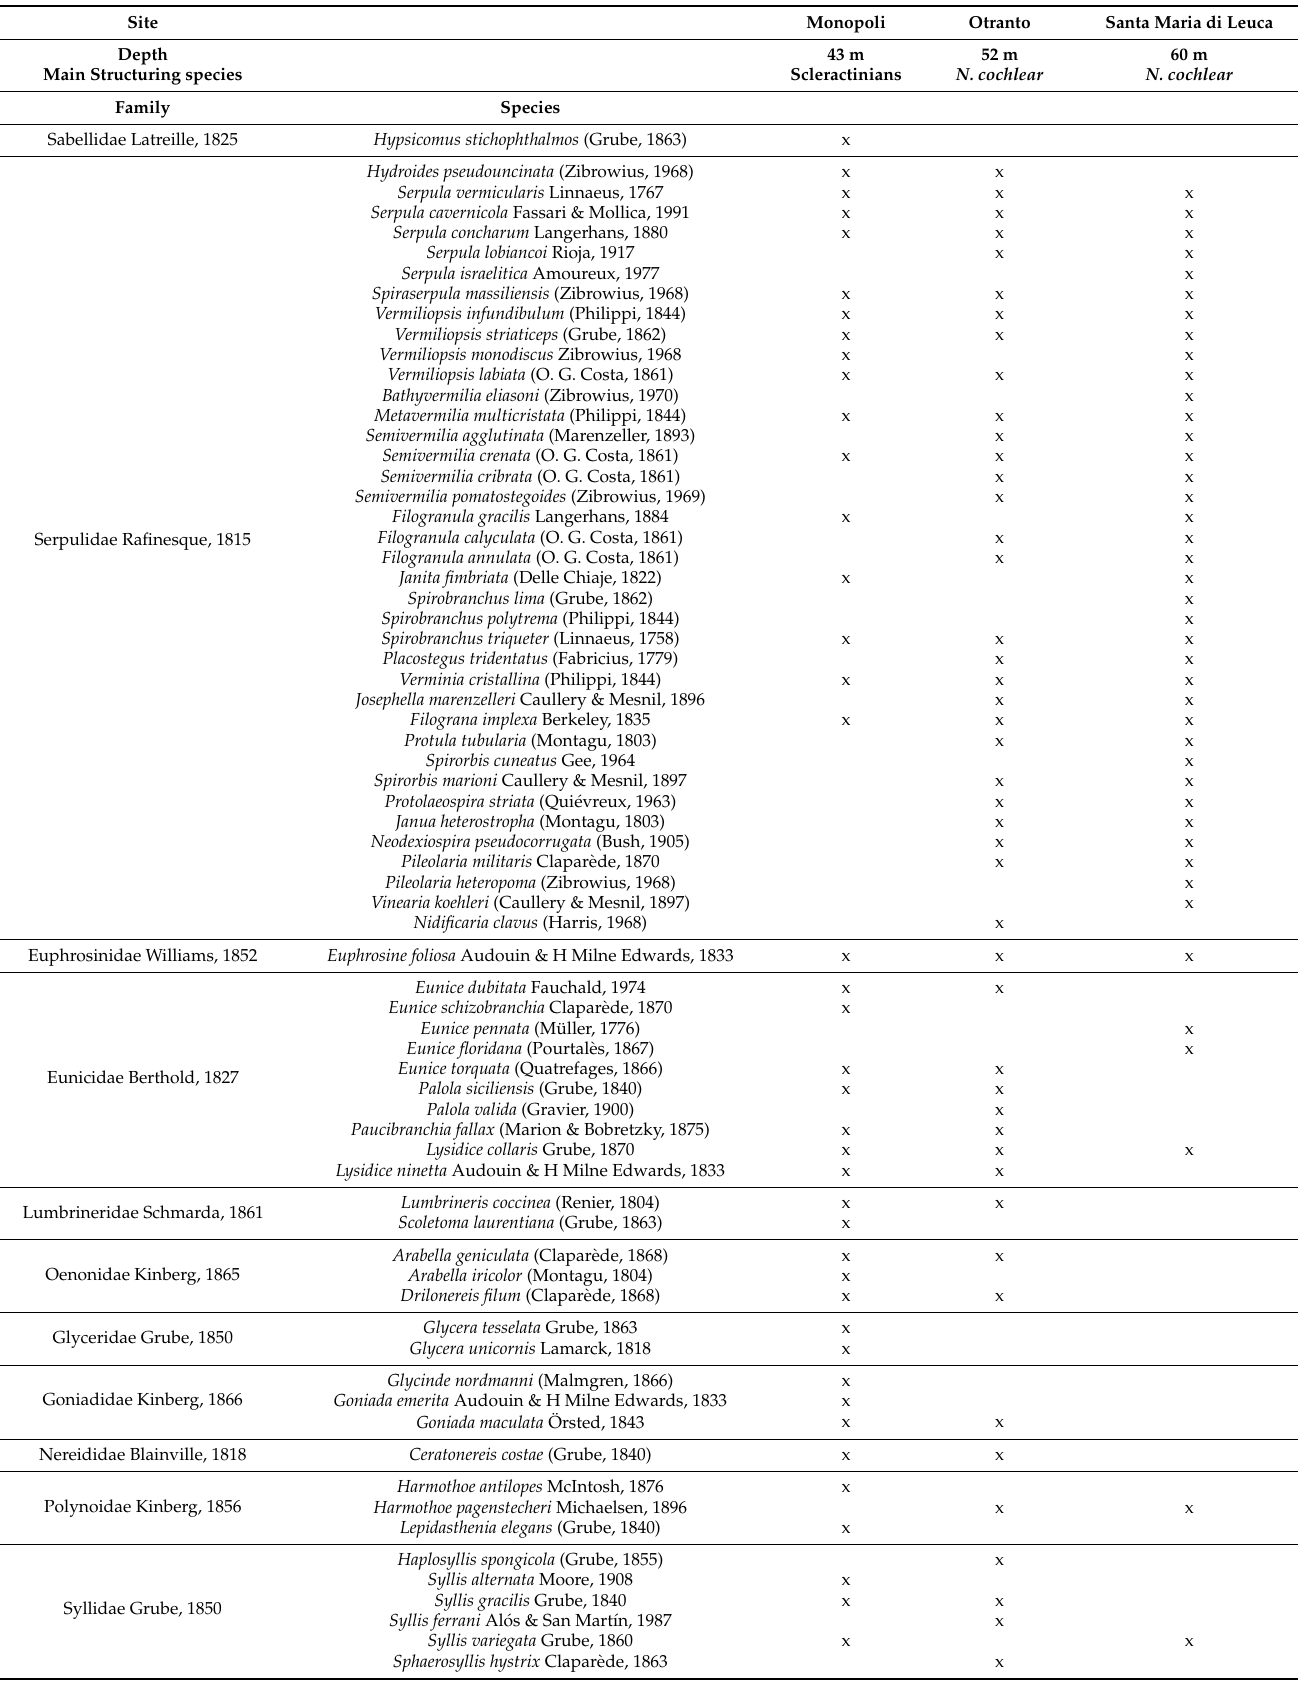
Table 1. List of polychaete species recorded at three sites along the Apulian